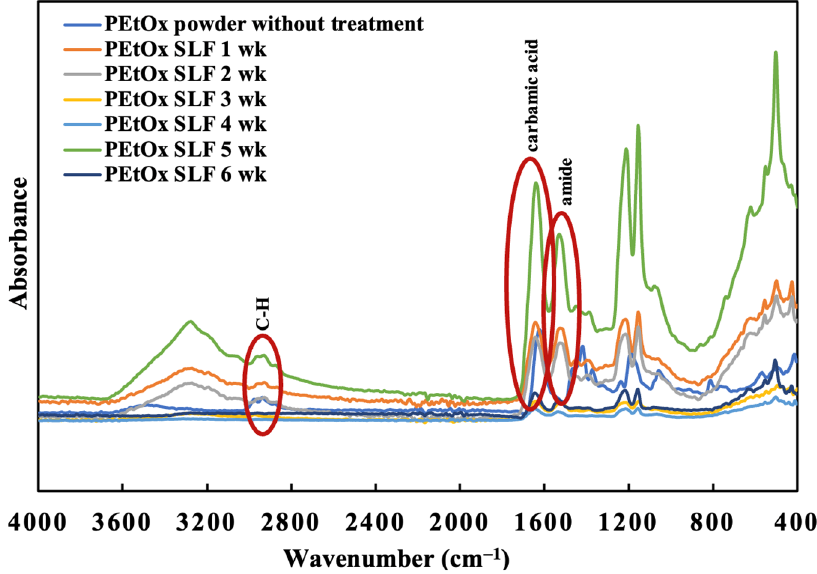
Figure 9. FTIR spectra of PEtOx powder before and after the incubation period of six weeks in